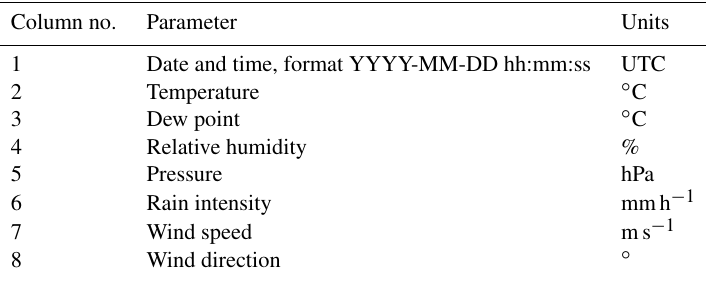
Table H1. Airport weather station